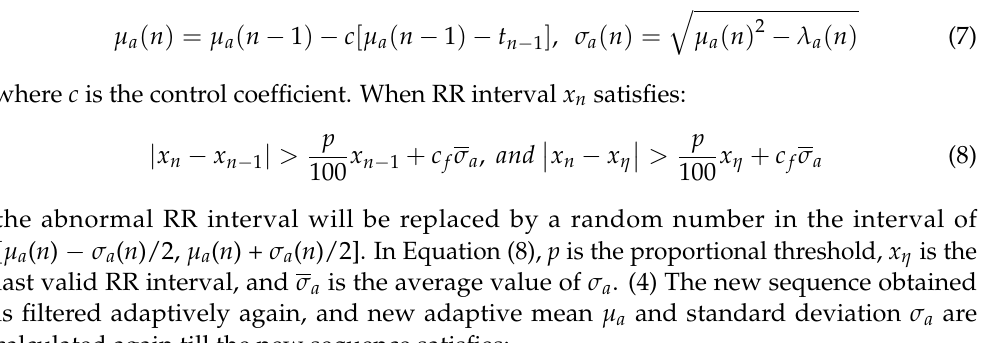
Figure 10. RR interval from ECG signal.